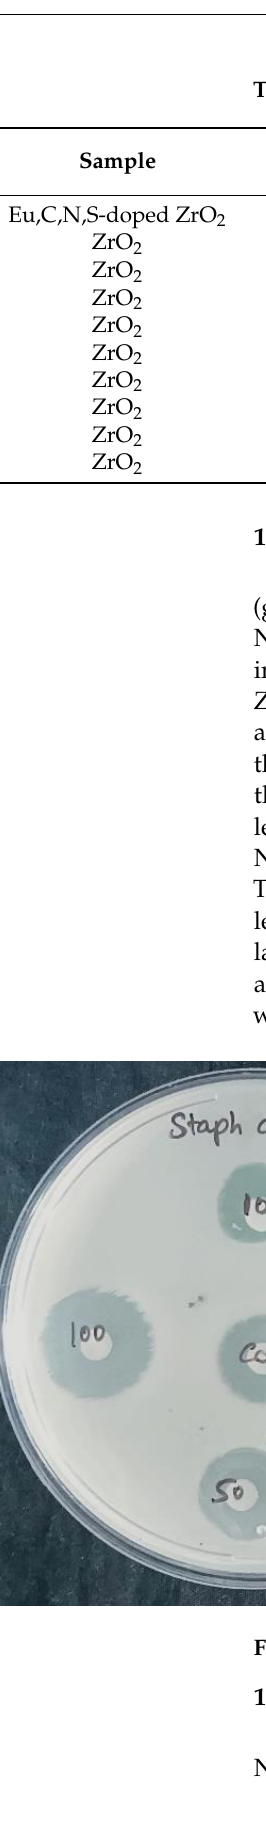
Table 1. Photocatalytic dye degradation comparison table of ZrO 2 NPs.